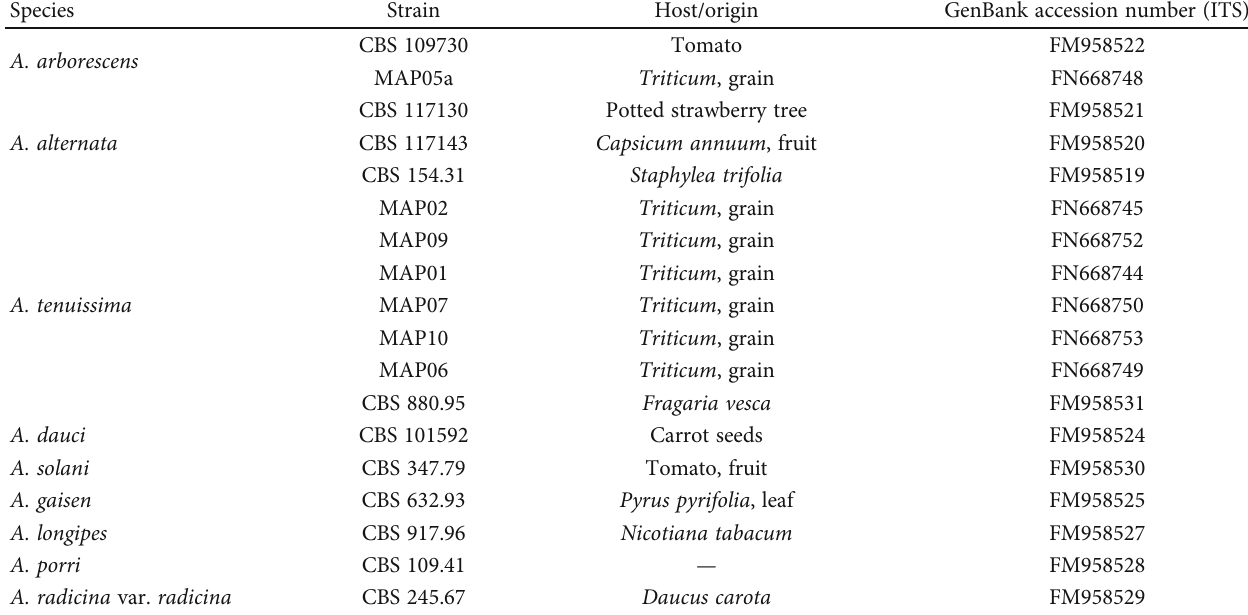
Table 3: Reference strains of Alternaria spp. used in this study and their accession numbers.